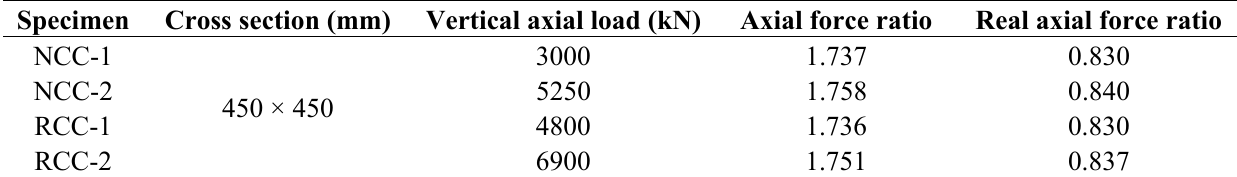
Table 3. The vertical load imposed on columns and the corresponding initial axial force ratio. Specimen